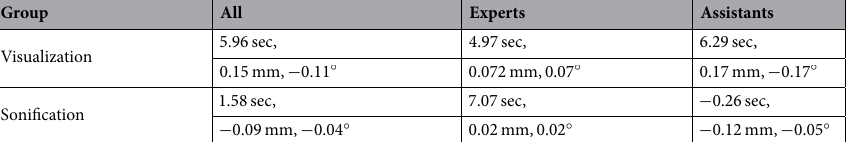
Group All Experts